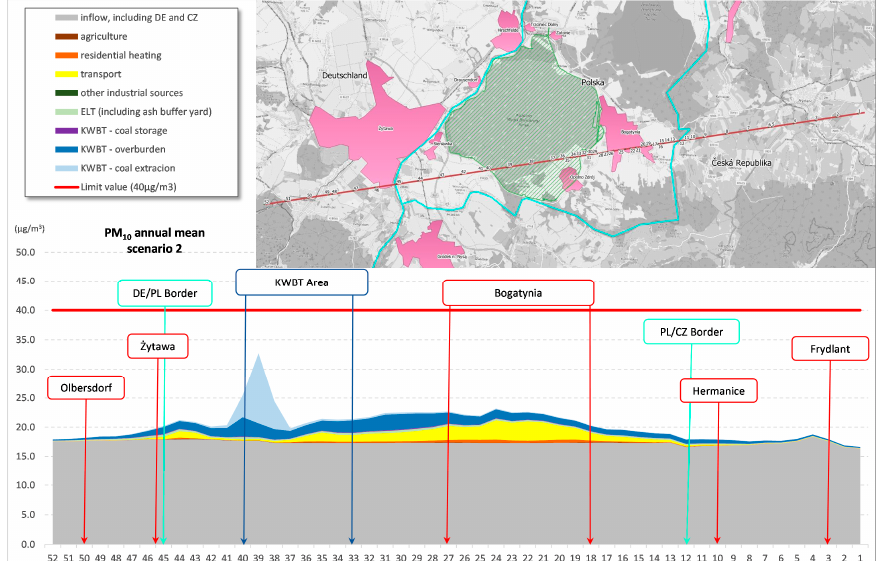
Figure 20. Profile of annual mean concentrations of PM 10 between Olbersdorf and Frydlant, considering the shares of individual source groups in scenario 2 (source: own study).